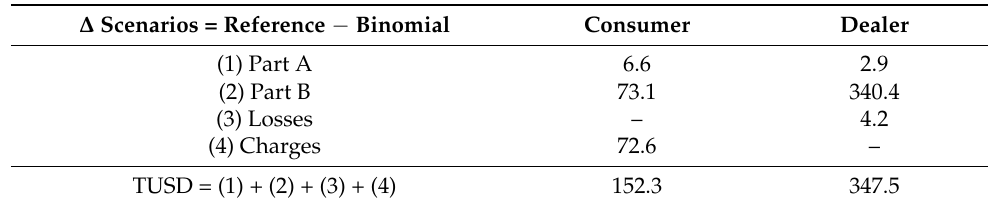
Table 18. Cumulative benefits of the binomial tariff policy, until 2030, in the distribution companies of the Enel group, in million